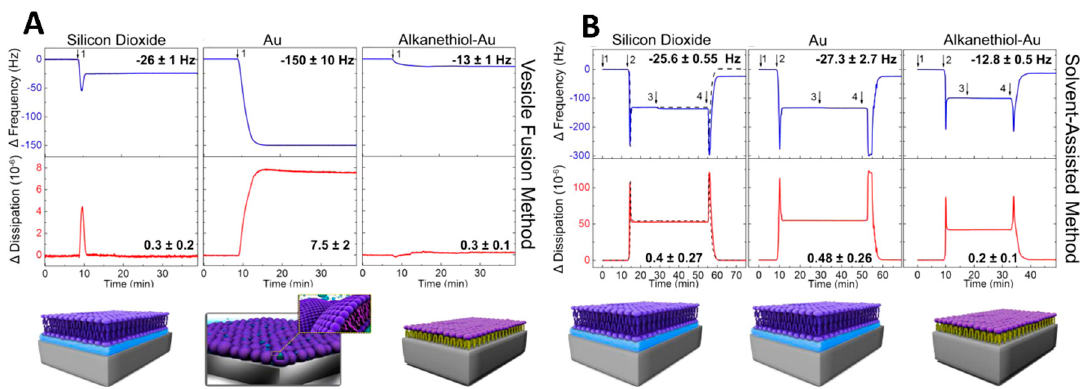
Figure 13. QCM-D monitoring of vesicle fusion and solvent-assisted lipid bilayer (SALB) methods on three different substrates. QCM-D frequency shift Δ f (blue) and dissipation shift ( Δ D, red) for the third overtone (n = 3) are measured as a function of time during lipid adsorption onto silicon dioxide, gold, and alkanethiol-coated gold. Panel ( A )corresponds to the vesicle fusion method. DOPC lipid vesicles are added at t = 10 min (arrow 1) after establishing the baseline for the frequency and dissipation shifts. Panel ( B )corresponds to the SALB formation method. Arrows indicate the injection of buffer (10 mM Tris, 150 mM NaCl, pH 7.5; (1)), isopropanol (2), lipid mixture (0.5 mg/mL DOPC lipid in isopropanol; (3)), and buffer exchange (4). The dashed curve in panel B represents the control experiment in which lipid is not injected. The final values of Δ f and Δ D for each surface are reported. All values are given as the mean of at least three runs. The schematics show the proposed assembled lipid structures as inferred from the final frequency and dissipation shifts [352]. Reproduced from Tabaei et al. (2014) with permission (Copyright © American Chemical Society 2014).